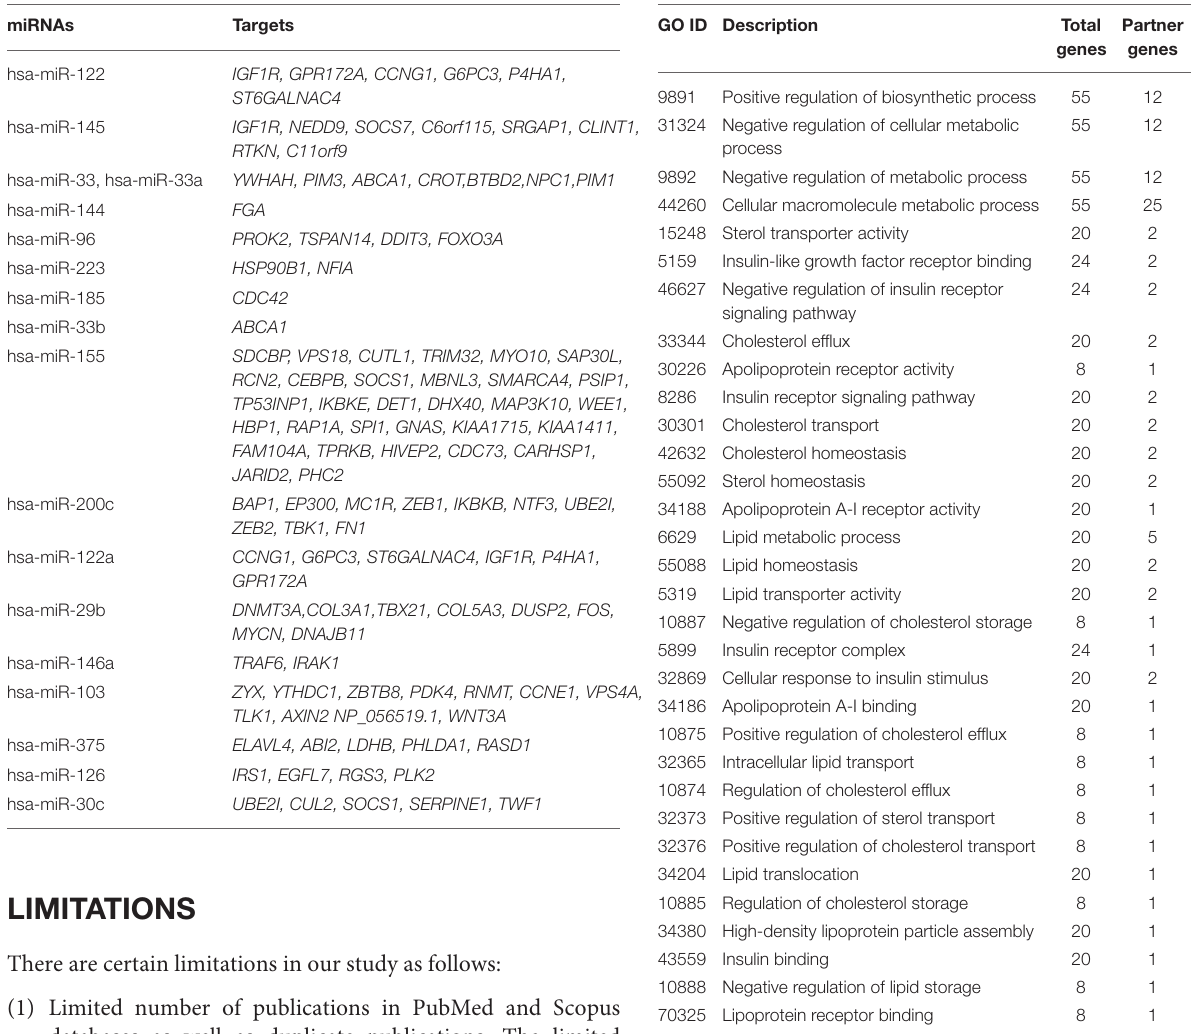
TABLE 6 | Top significant related gene ontology terms of CyTargetLinker targeted genes analyzed by BINGO on